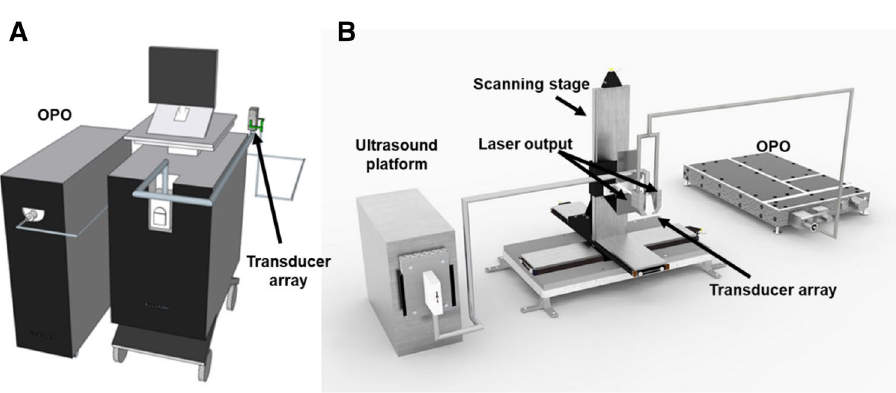
Figure 9. Experimental setups for the imaging systems: ( A ) Commercial PA system (Vevo LAZR-X) equipped with ultrasound detector MX550D, of which the central frequency is 40 MHz. ( B ) Self-developed handheld photoacoustic real-time imaging system. The system includes a pulsed laser with repetition rate of 100 Hz, while the operation wavelengths for the signal port is from 680 to 980 nm, a XYZ scanning stage with a customized handheld fiber bundle hosted on it and a research ultrasound platform for processing the imaging purposes. The detector of the ultrasound platform is a 128-element linear transducer array, which is in the middle of the bifurcated fiber